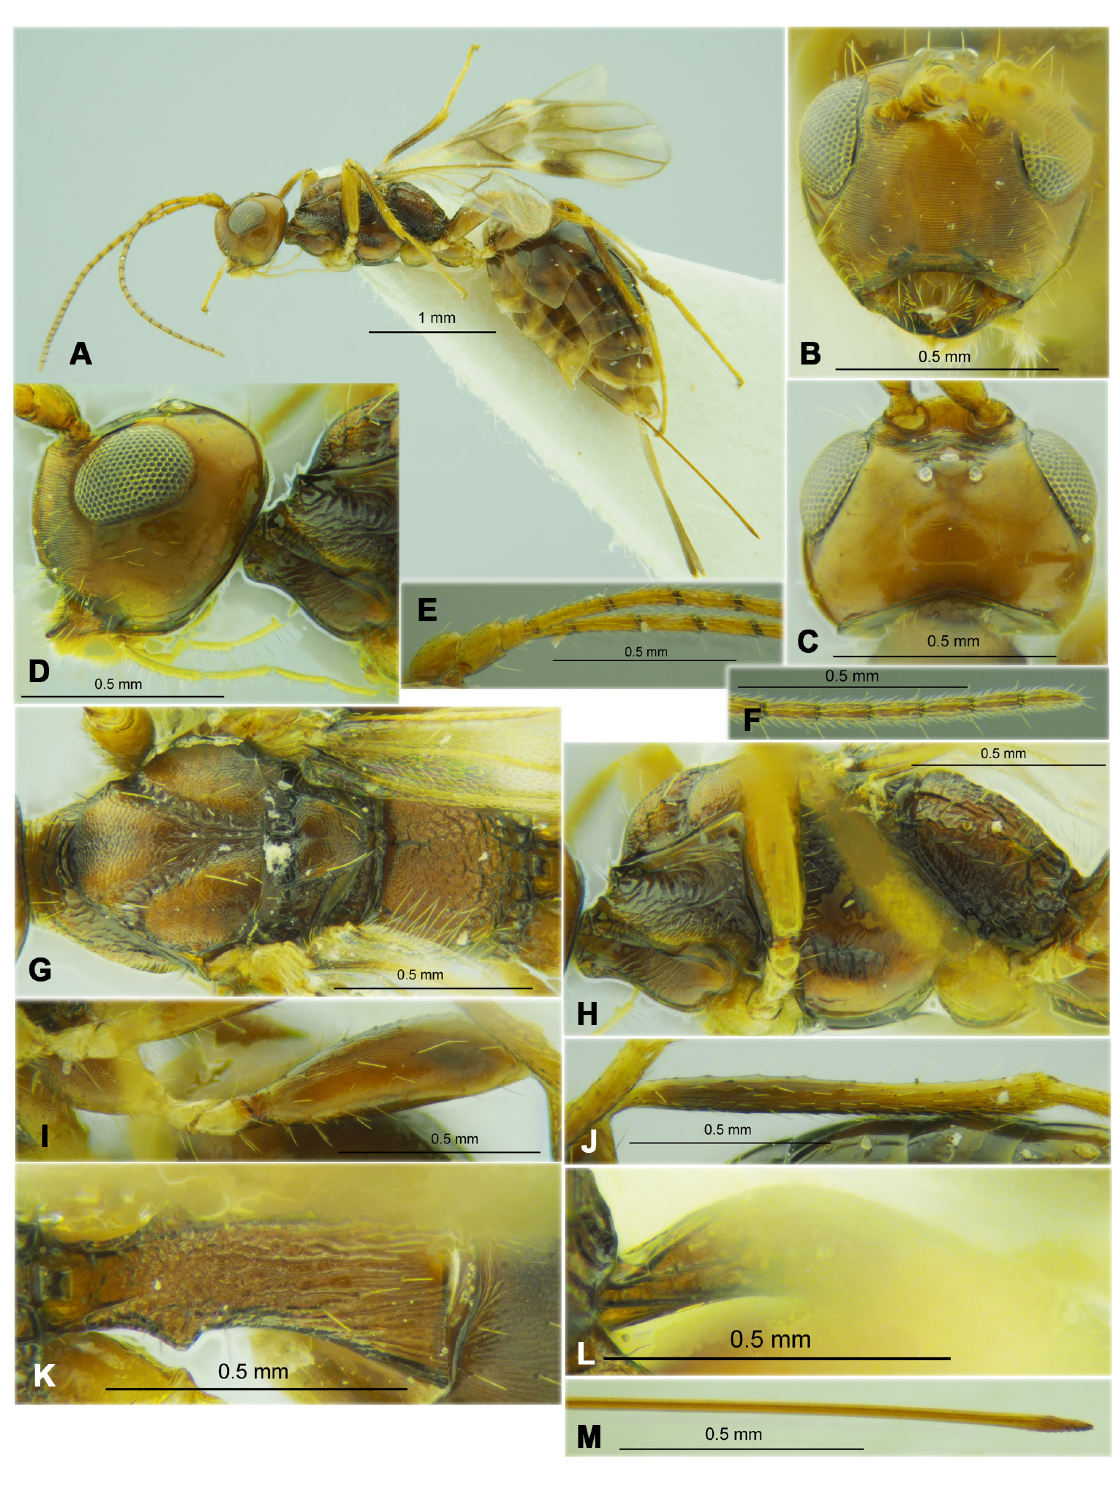
Fig. 16. Spathius alkadanus Belokobylskij sp. nov., holotype, ♀ (RMNH). A . Habitus, lateral view. B . Head, front view. C . Head, dorsal view. D . Head, lateral view. E . Basal segments of antenna. F . Apical segments of antenna. G . Mesosoma, dorsal view. H . Mesosoma, lateral view. I . Hind coxa and femur. J . Hind tibia. K . Petiole of metasoma, dorsal view. L . Petiole of metasoma, lateral view. M .